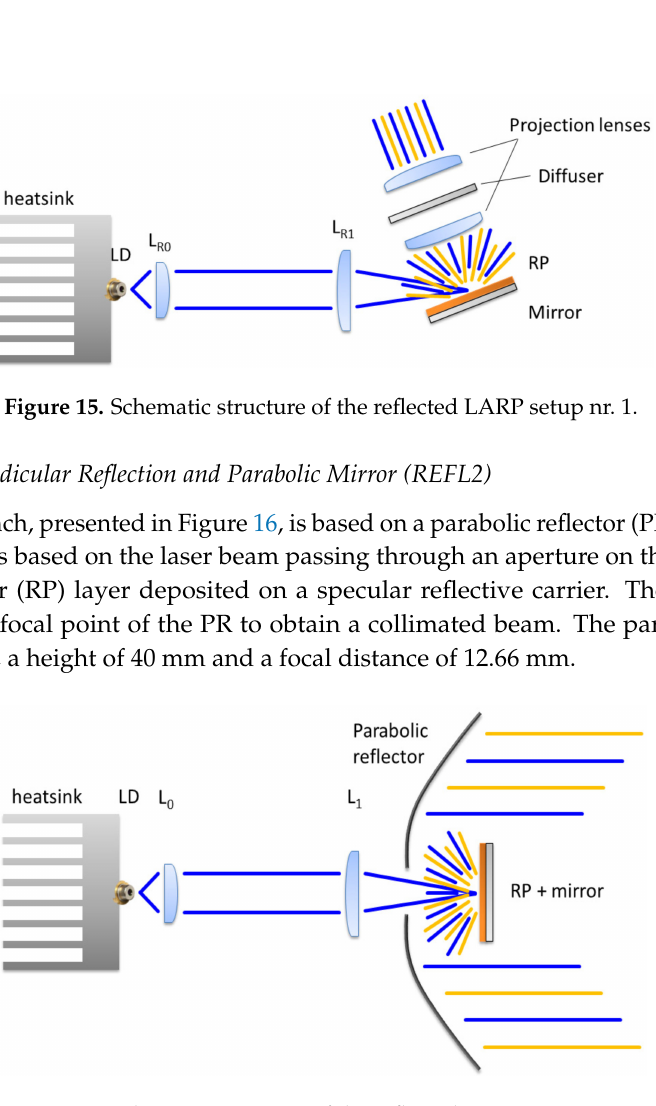
Figure 16. Schematic structure of the reflected LARP setup nr.